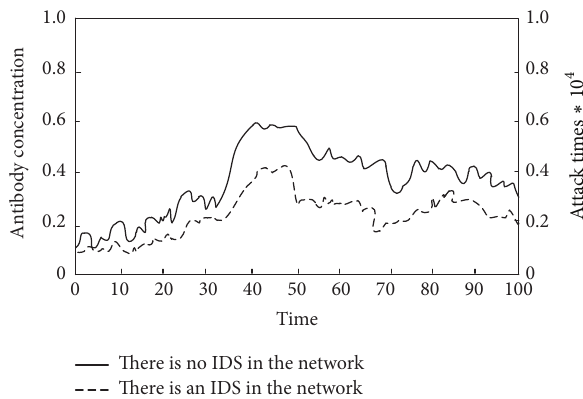
Figure 4: Host 𝑠 1 antibody concentration on the condition of the number of different attack types.